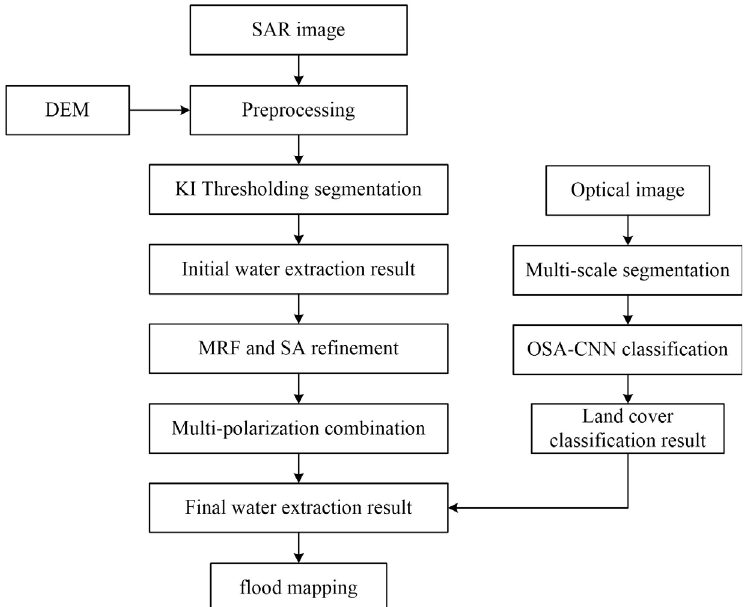
Figure 3. Main technical process of proposed